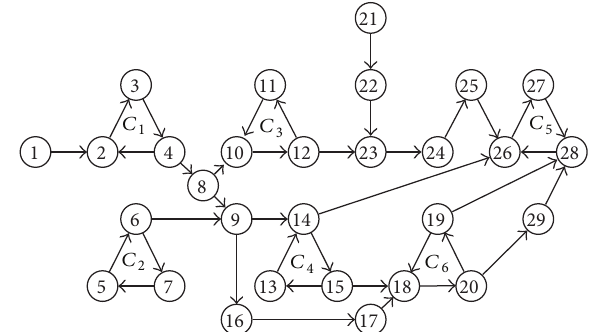
Figure 2: An MW-graph 𝐻 with 𝐶(𝐻) = {𝐶 1 ,...,𝐶 6 } .